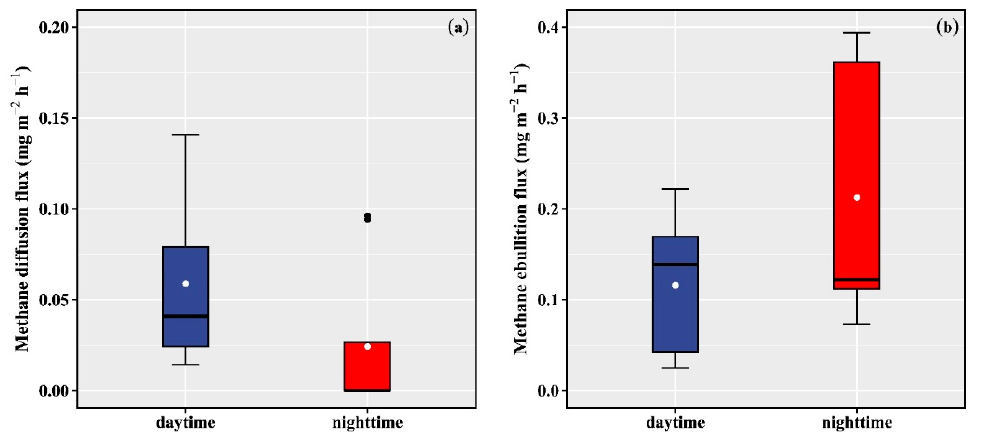
Figure 2. Diel differences in CH 4 diffusion flux ( a ) and ebullition flux ( b ). (The black lines represent the median and white dots indicate the mean; lower and upper edges represent 25th and 75th, respectively; whiskers represent confidence intervals of 1.5 times the interquartile range; black dots indicate outliers).